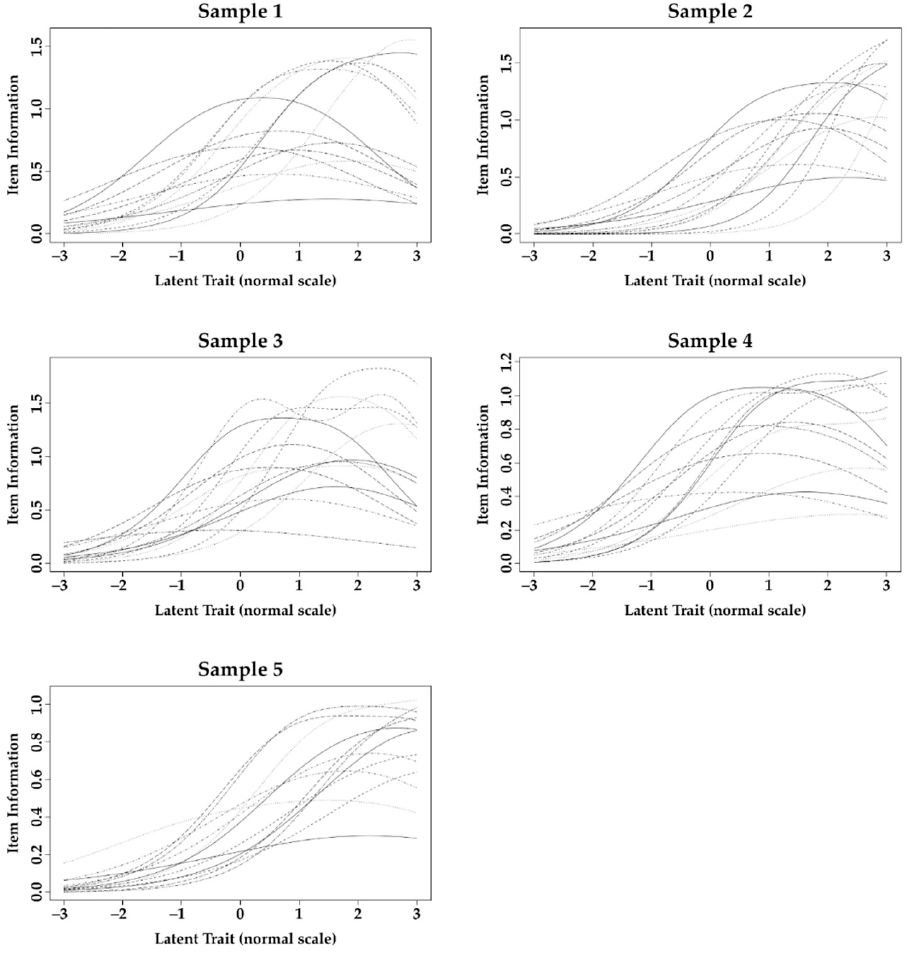
Figure 2. Item information function obtained from Differential Item Functioning analysis of the items of Oral Health Impact Profile-14 applied to the samples of the studies.